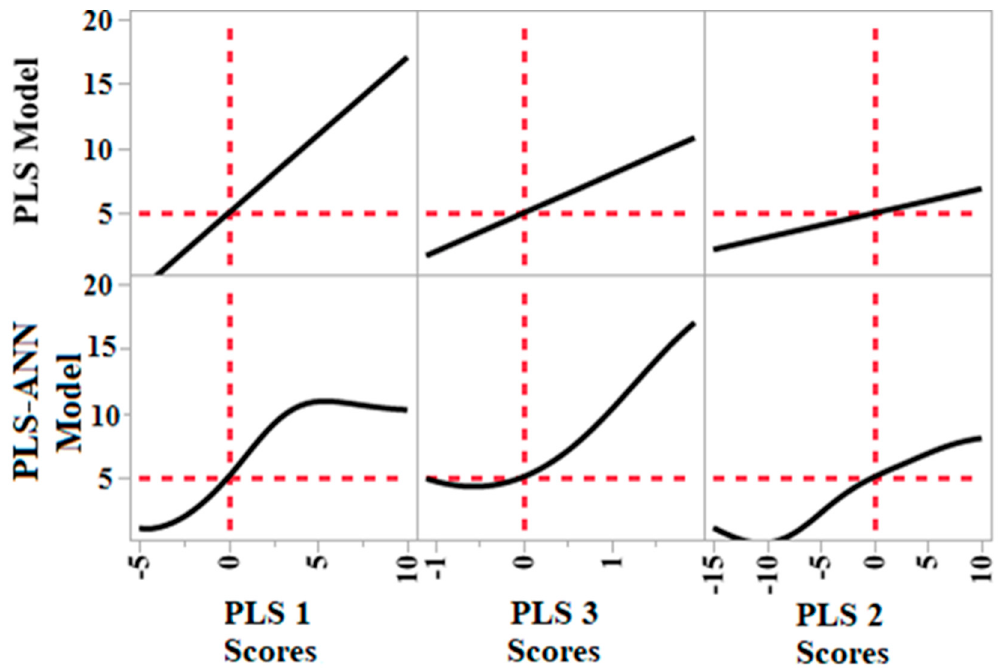
Figure 7. Linear and non-linear relationship of PLS components and chlorophyll-a.